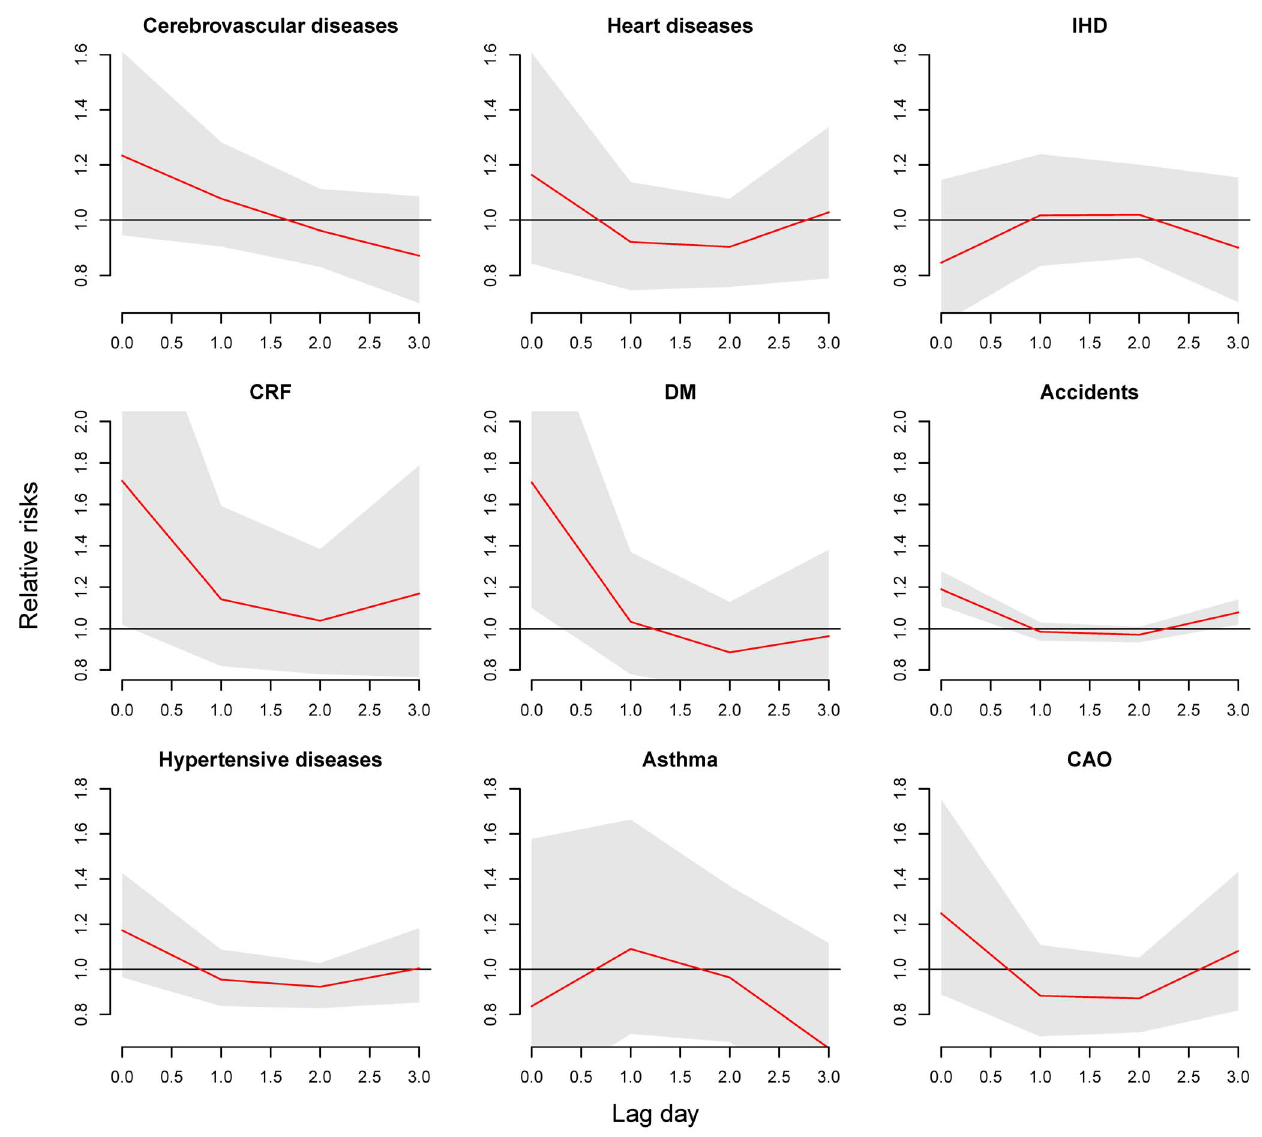
Figure 3. Lag effects of a temperature of 32 6 C on cause-specific emergency room visits compared to a centered temperature of 26 6 C for cerebrovascular diseases, 18 6 C for CRF, DM, and accidents, and 30 6 C for hypertensive diseases, asthma, and